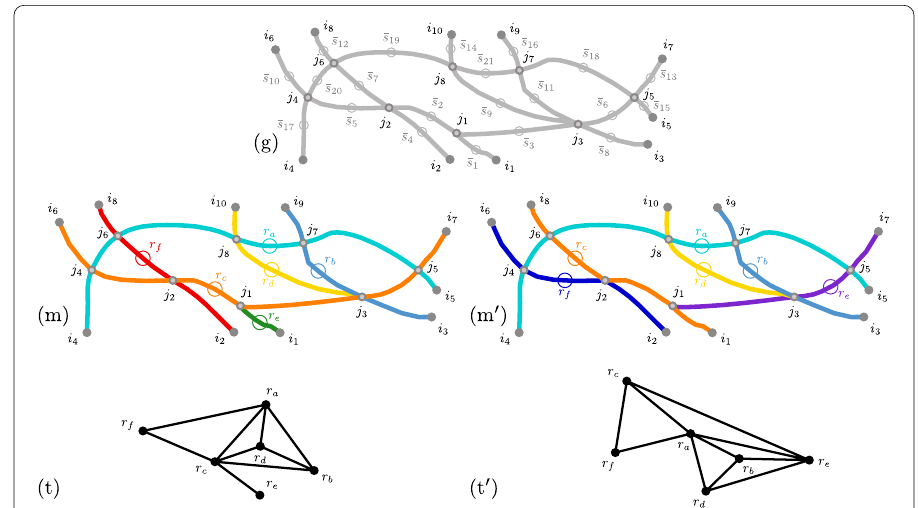
Fig. 1 Notional urban street network meant to pattern throughout this paper a real-world urban street network. The planar graph representation ( g ) emphasizes a literal geometric interpretation where junctions j ∗ (and impasses i ∗ ) are nodes and street-segments ¯ s ∗ are edges. The street maps ( m ) and ( m ′ ) show two of the possible configurations of streets associable to graph ( g ). The information networks ( t ) and ( t ′ ) emphasize the topological information contained in street maps ( m ) and ( m ′ ), respectively: they associate streets r ∗ to nodes and they link streets sharing common junctions j ∗ . Information networks of self-organized or unplanned urban street networks exhibit in general a scale-free valence distribution, namely, they are scale-free networks. This observational fact has led us to a fluctuating model for which configurations of streets are fluctuating as part of a social process. So, along this paper, a street map such as ( m ) or ( m ′ ) is abstracted as a state (see Footnote 1) of a fluctuating